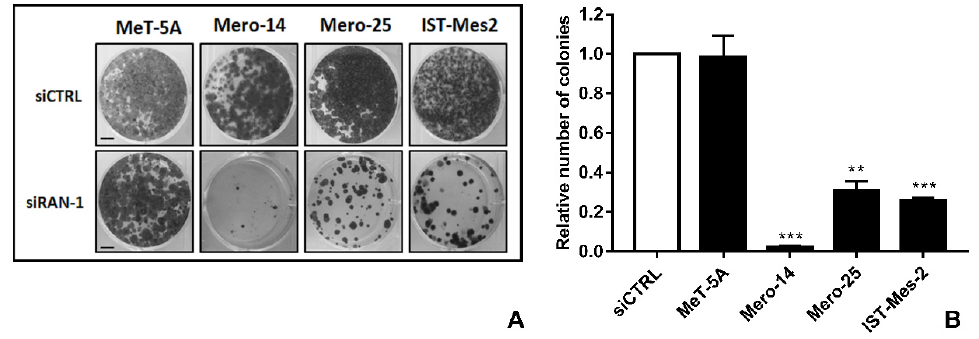
Figure 7. RAN silencing and colony formation ability. ( A ): Representative pictures of colonies in MeT-5A and MPM cell lines fixed and stained 14 days after treatment with siCTRL or siRAN-1. Scale bar: 1 cm. ( B ): Histogram represents number of colonies measured 14 days after silencing with siRAN-1, compared to siCTRL. Error bars are SEM of three di ff erent experiments, each performed in triplicate. Statistical significance is indicated by *, where ** p < 0.01; *** p < 0.001, compared to control